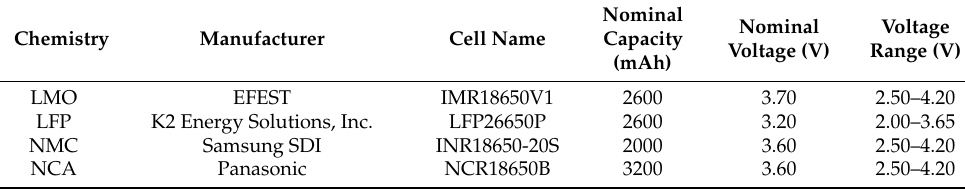
Table 5. Cell specifications for each